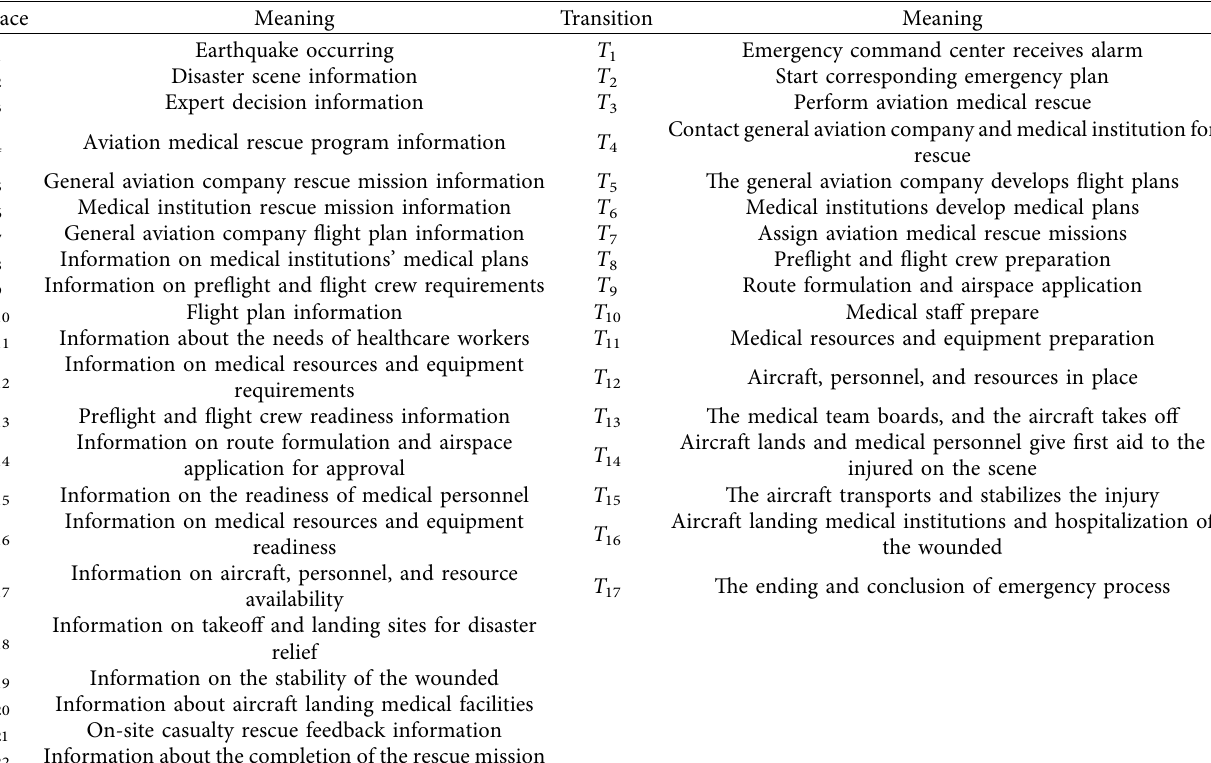
Table 1: The meaning of place and